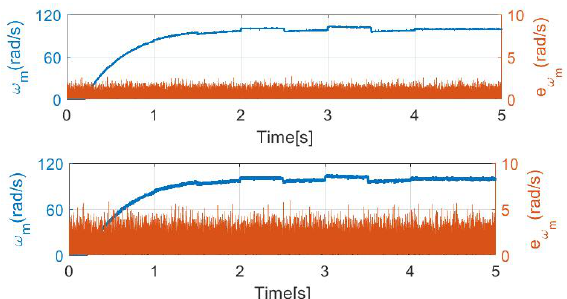
Figure 8. Speed control with noise signals with a variance of 0.001 ( upper ) and 0.005 ( bottom ).